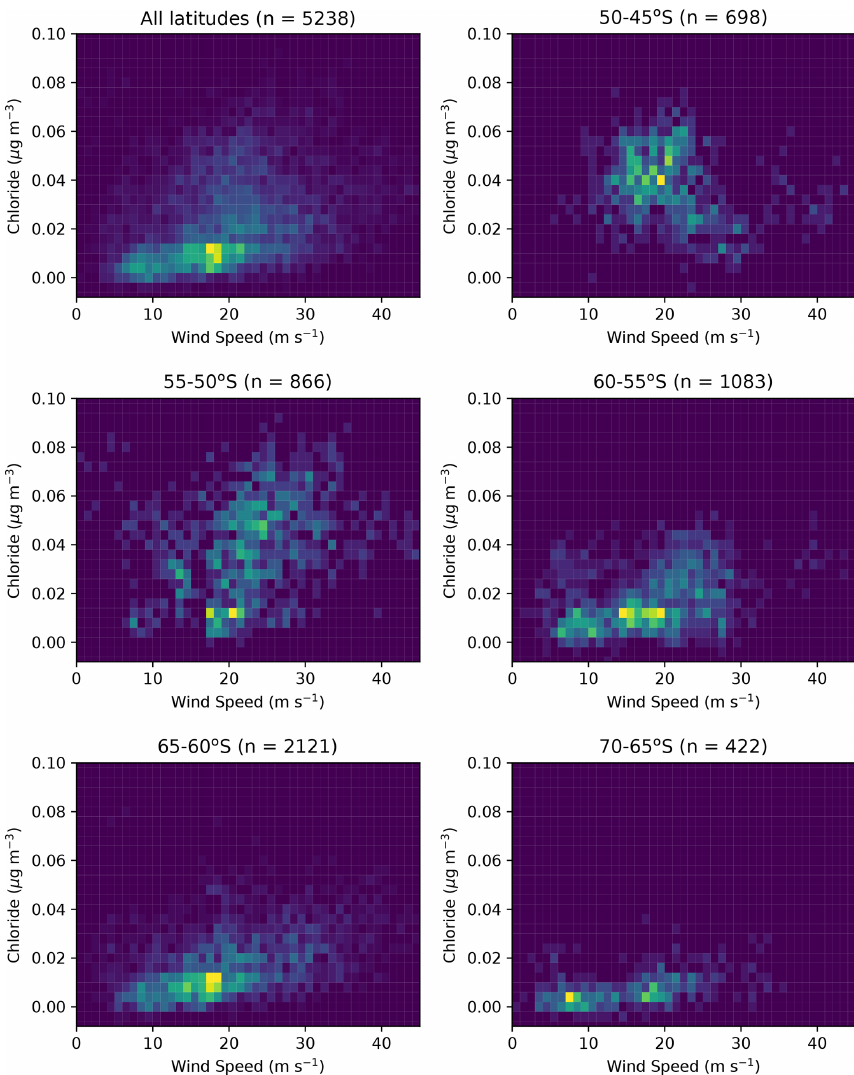
Figure A9. Two-dimensional histogram showing the positive correlation between wind speed and chloride (a tracer for sea salt measured with the ToF-ACSM) across different latitude